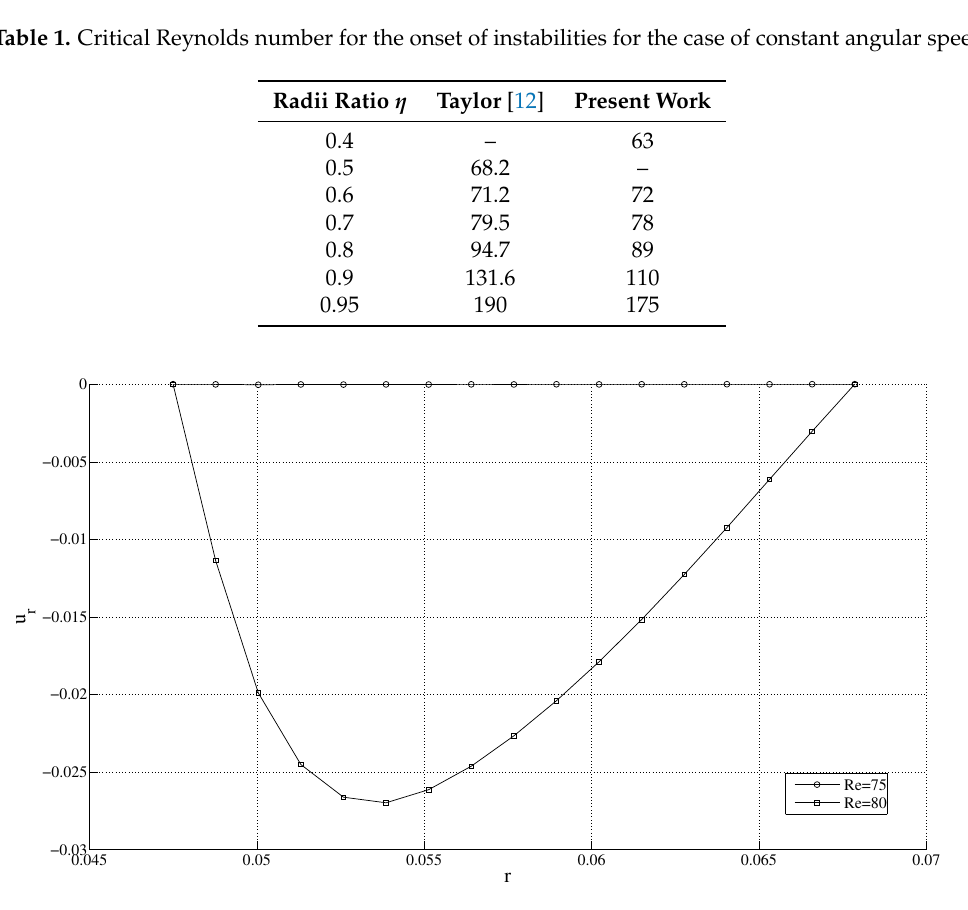
Figure 6. Variation of the radial velocity with radius for different Re for the constant angular speed